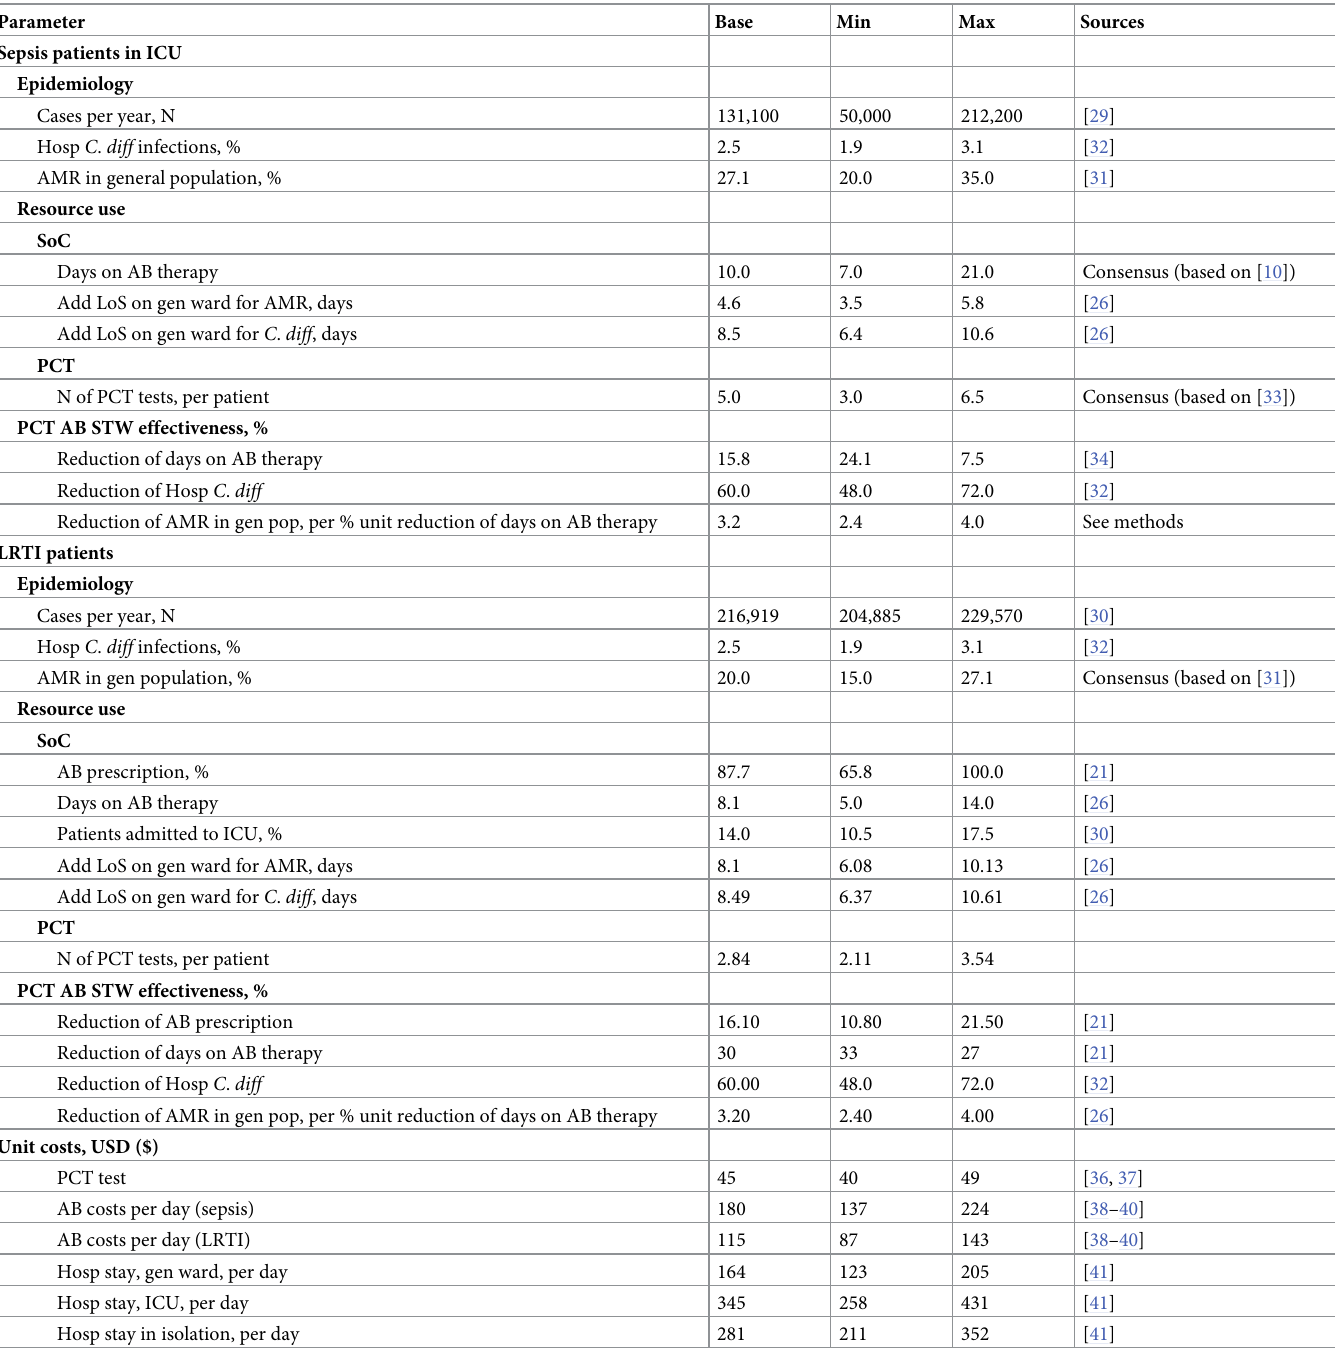
Table 1. Model parameters for sepsis and LRTI. Epidemiological, resource use, effectiveness of PCT antibiotic stewardship and unit costs. Argentina, 2020.